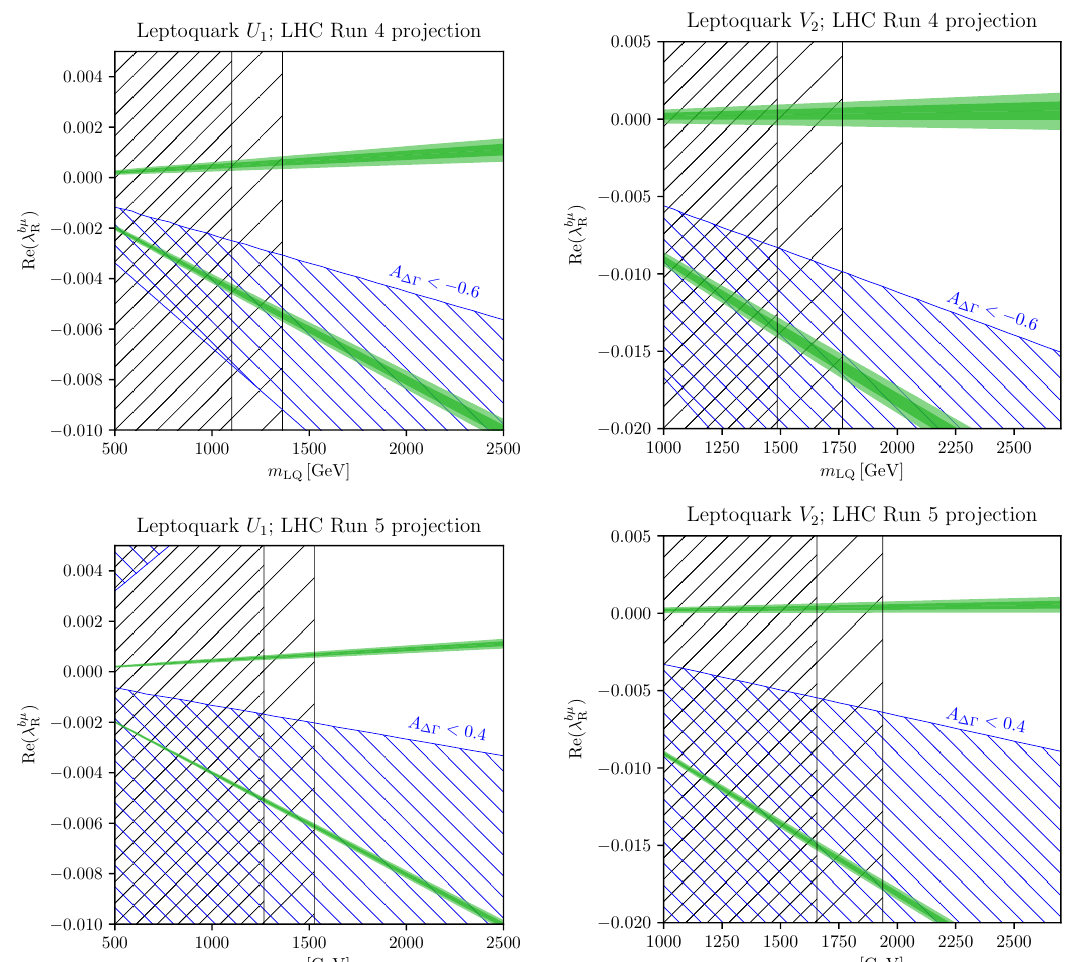
Figure 8 . Future constraints in the mass vs. coupling planes for the LQs U the scenarios (6.9) and (6.10). The (cid:12)rst row is for the \Run 4" scenario while the second row marks \Run 5". The green 1 (cid:27) - and 2 (cid:27) -regions correspond to the anticipated future experimental sensitivity of the branching ratio, assuming the SM central value (3.5). The black //-hatched regions show the extrapolated exclusions from direct searches. The more densely hatched region corresponds to minimal LQ production, while the more coarsely hatched region is for YM-like production. The blue -hatched region would be excluded at the 2 (cid:27) level by a measurement of A (cid:1)(cid:0) with SM-like nn central